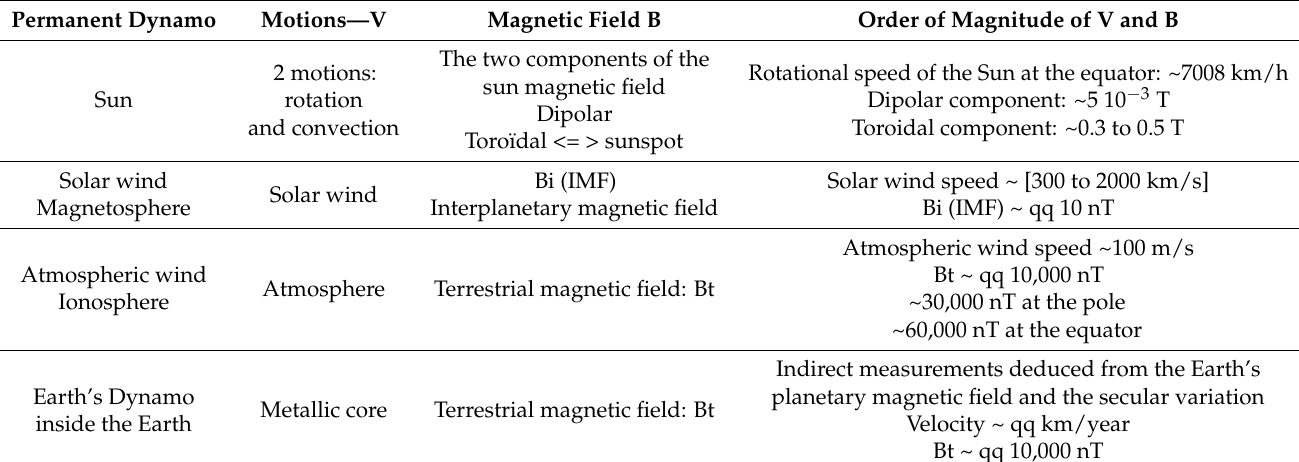
Table 1. Large-scale permanent